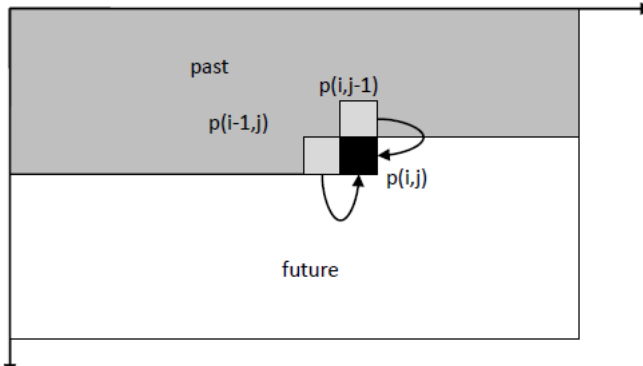
Figure 2. Operation sequence schematics of the 2D Kalman filter.